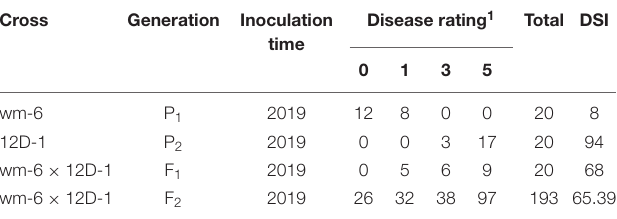
TABLE 1 | Disease evaluation of powdery mildew in wm-6, 12D-1, F 1 and F 2 plants at 12 days post inoculation with P . xanthii . Cross Generation Inoculation time